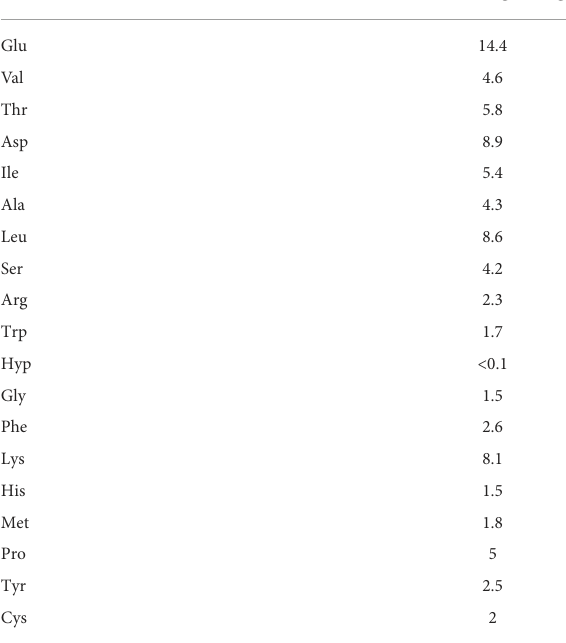
TABLE 1 Amino acid composition of